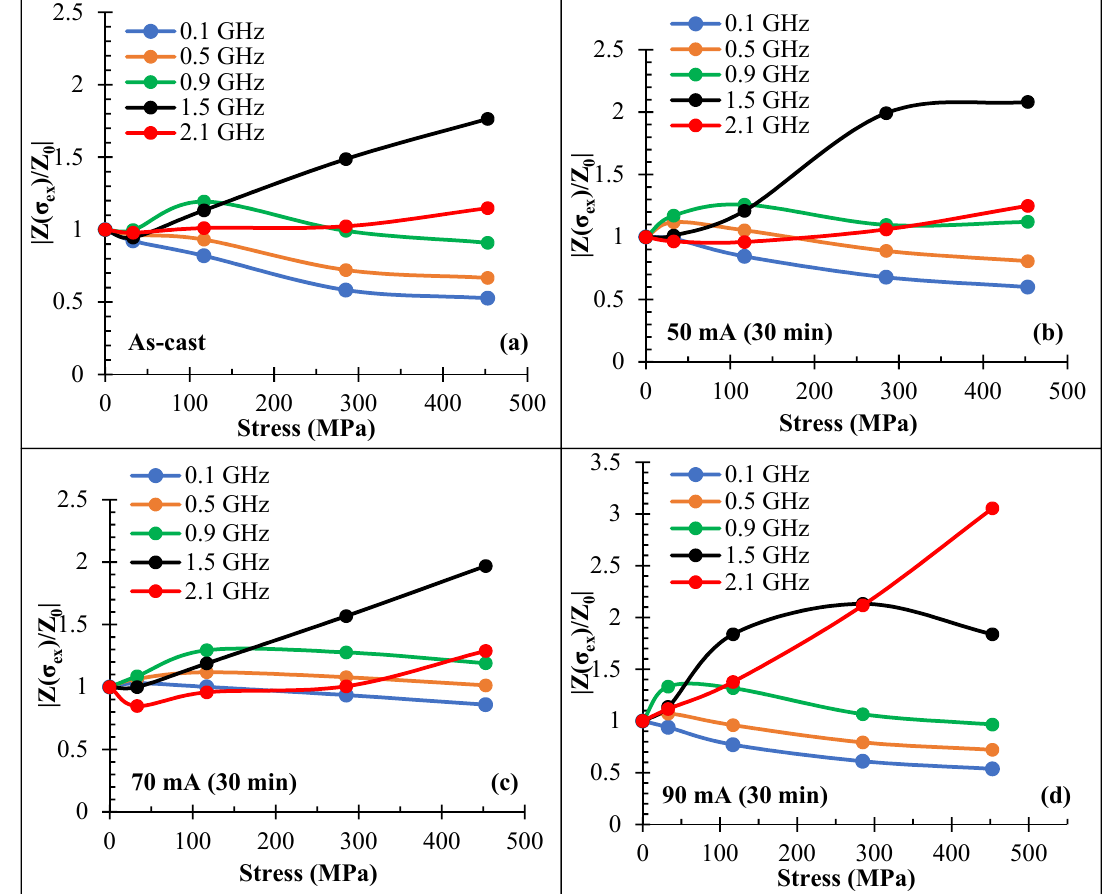
Figure 16. Stress dependence of MI at zero field ( Z ( H = 0)) for amorphous Co 71 Fe 5 B 11 Si 10 Cr 3 microwires (sample No3) in as-prepared state ( a ) and after DC current annealing at 50 ( b ), 70 ( c ), and 90 ( d ) mA for 30 min at different frequencies. | Z ( σ ex ) / Z | = | Z ( H = 0, σ ex ) / Z ( H = 0, σ ex = 0 ) . σ ex is the applied stress.